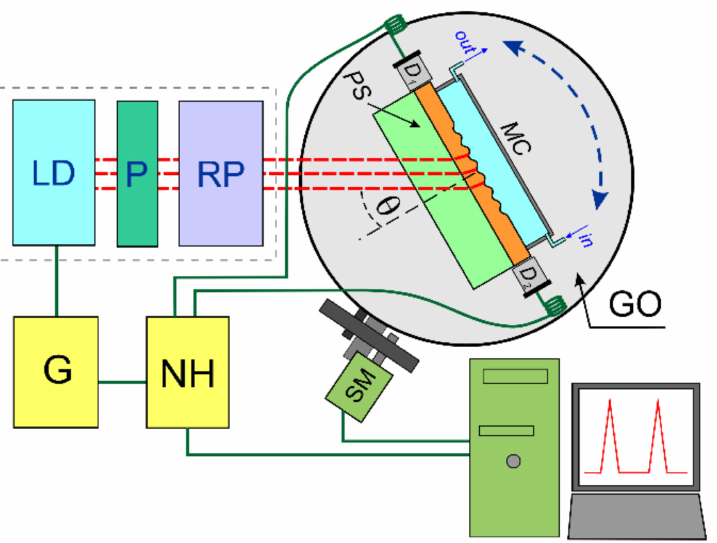
Figure 9. The schematic diagram of the measuring set-up. GO—goniometer, PS—planar sensor structure, D1, D2—photodiodes, MC—measuring chamber, LD—laser diode, P—polarizer, RP— polarization rotator, G—generator, NH—homodyne nanovoltmeter, SM—stepper